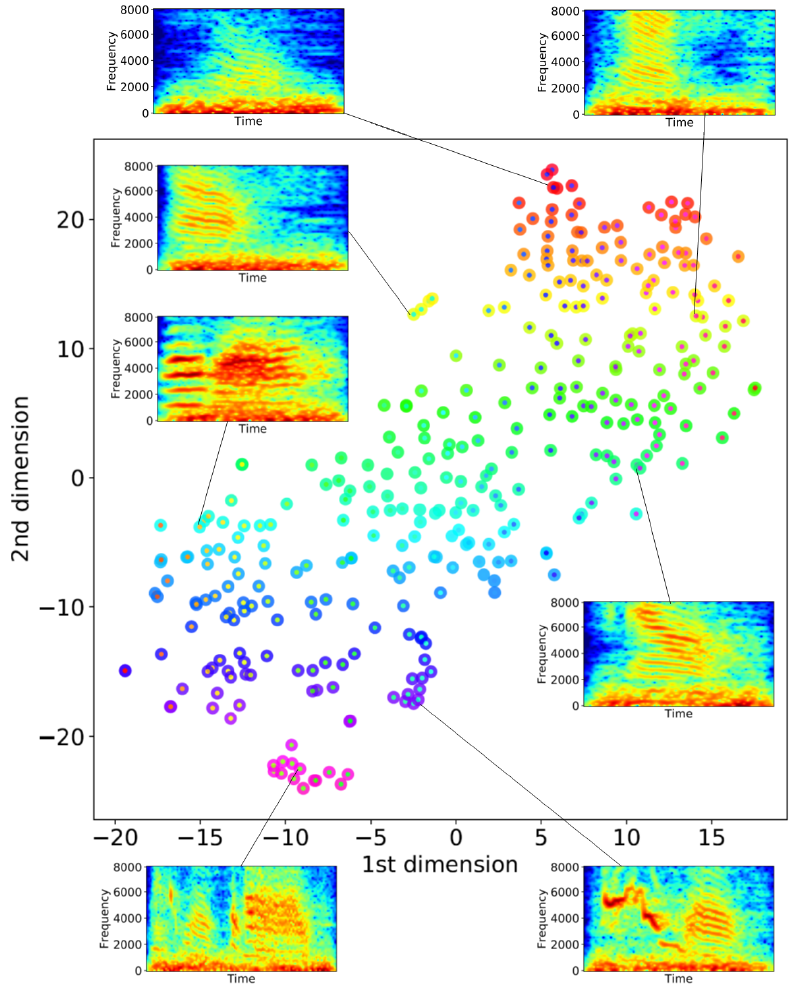
Figure 7. Distribution of localized sound sources from the recordings of the microphone array 4 in the feature space of t-SNE. All were localized in the 2D localization phase. The face color of each dot represented by the hue, saturation, and value color map corresponds to the position at the first dimension. The edge color represented by the gist-rainbow color map corresponds to the position at second